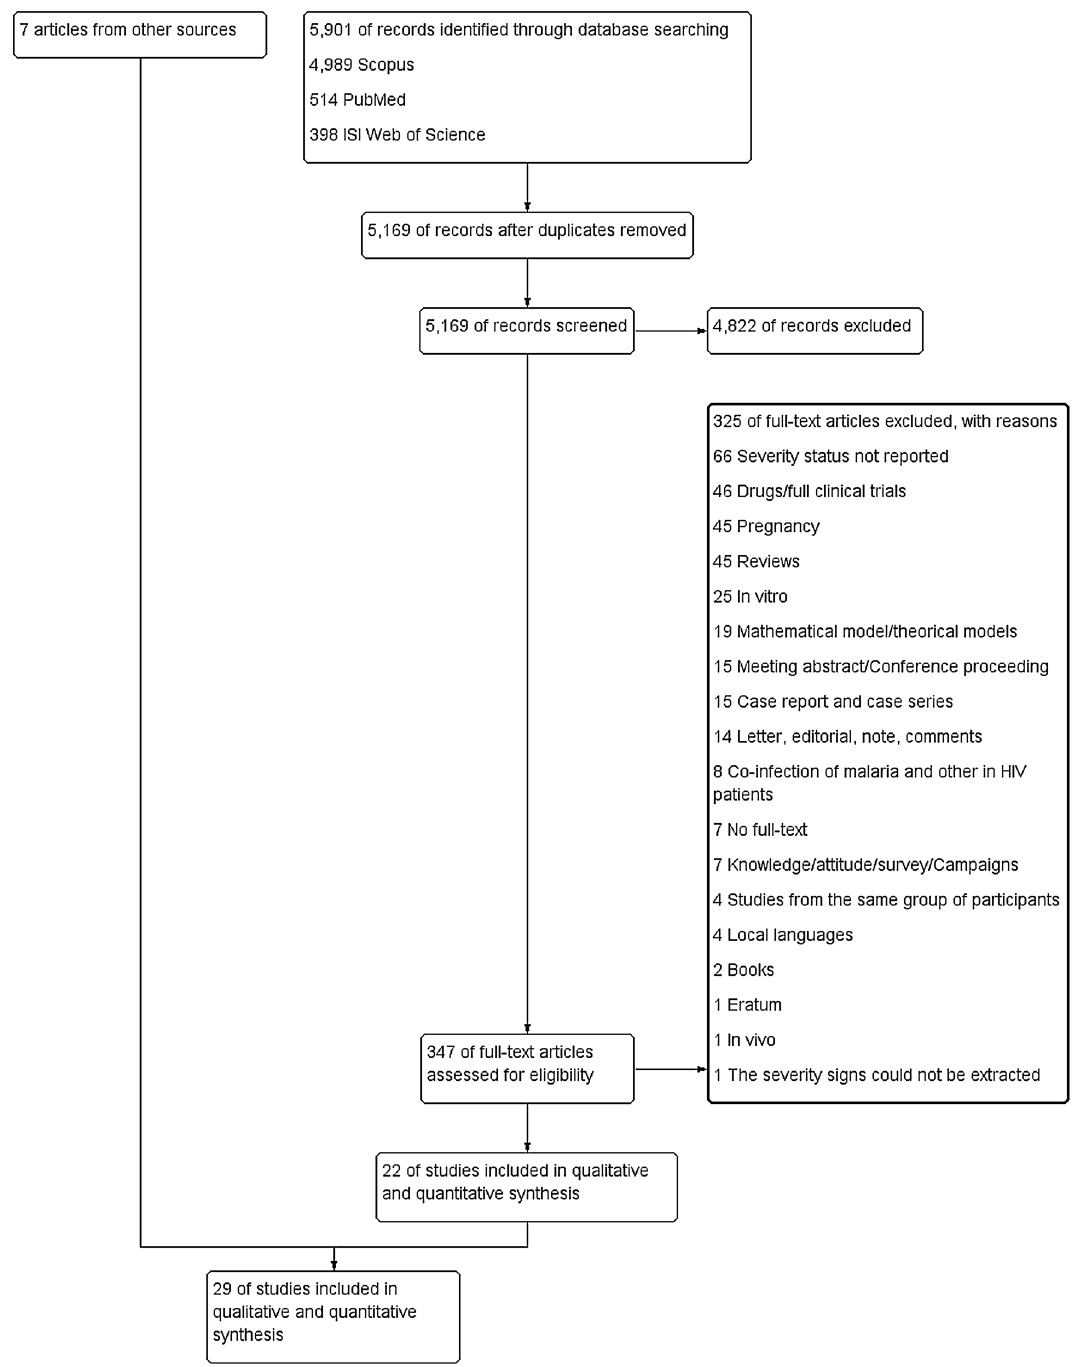
Figure 1. PRISMA diagram. Flowchart for study